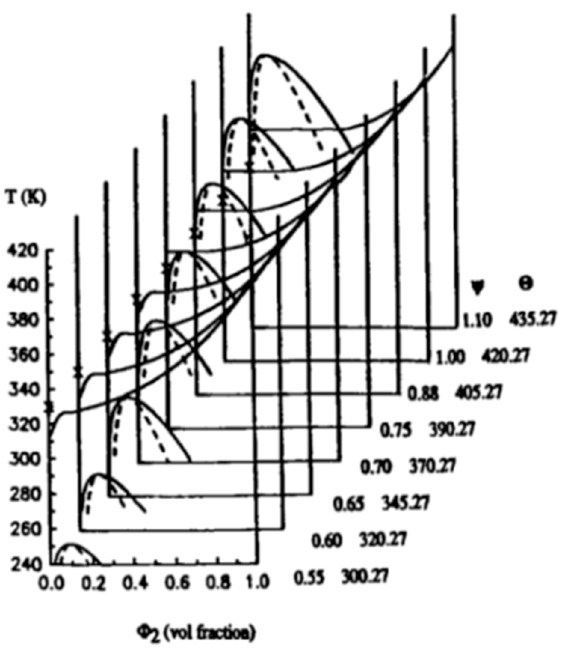
Figure 5. Effect of the interaction parameter ( χ ) on the phase diagram, adapted from [8] . Figure 5. E ff ect of the interaction parameter ( χ ) on the phase diagram, adapted from